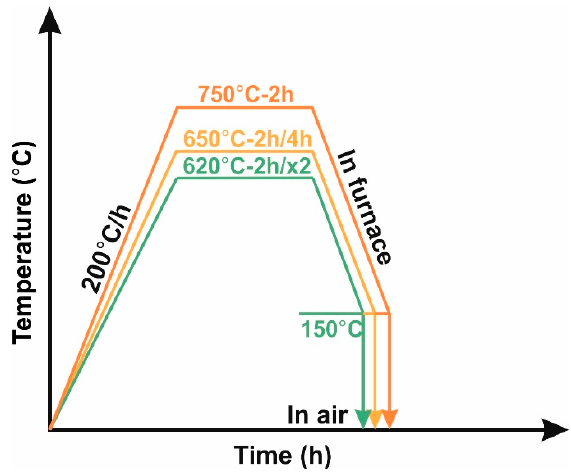
Figure 3. The heat treatment of the samples fabricated by deposition.